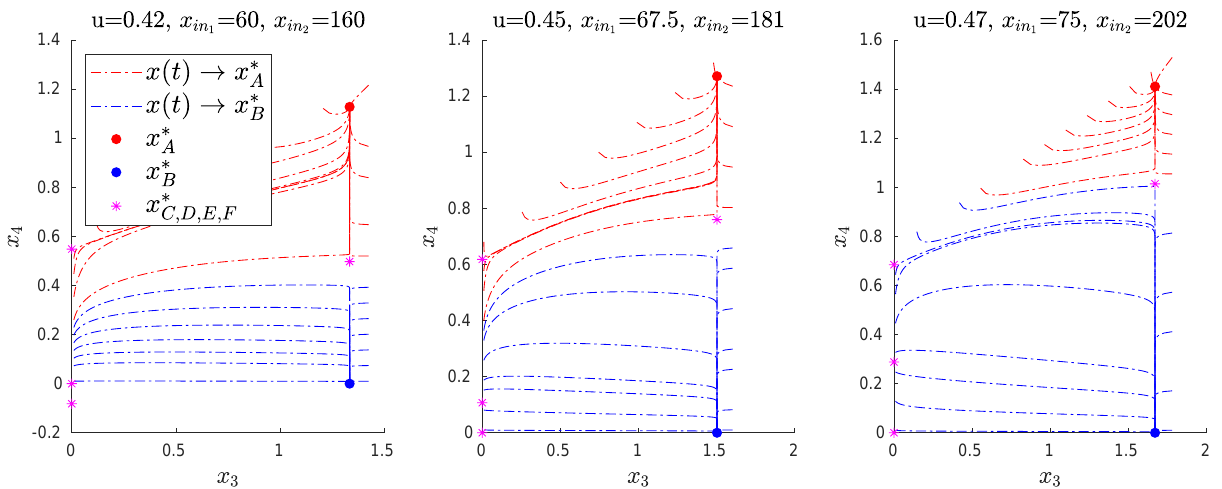
Figure 1: Phase plane with three different realizations of the anaerobic digestion process.